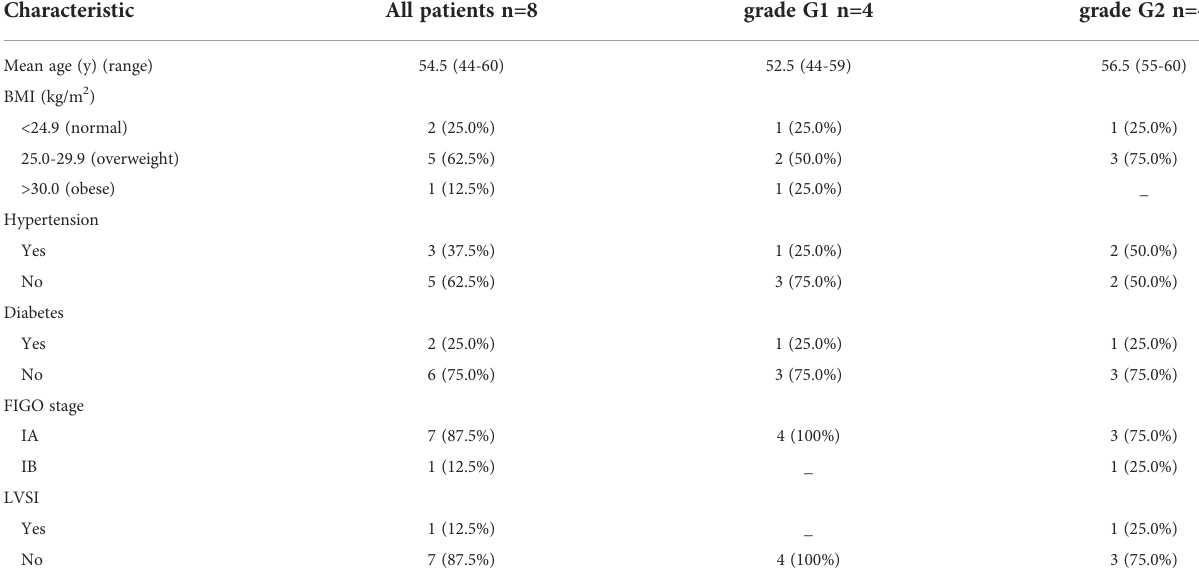
TABLE 1 Clinicopathological characteristics of the EAC patients included in the study.